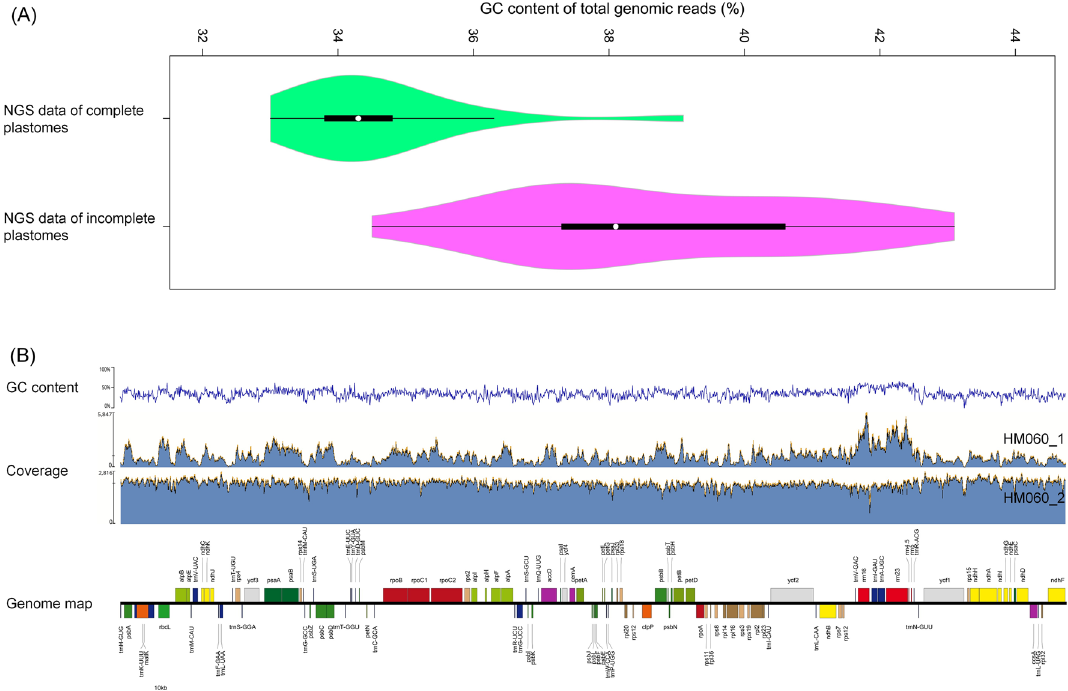
Figure 1. The relationship between GC content and plastome completeness. ( A ) Violin plot of the GC content between total genomic reads of complete and incomplete plastomes. ( B ) GC content fluctuation across